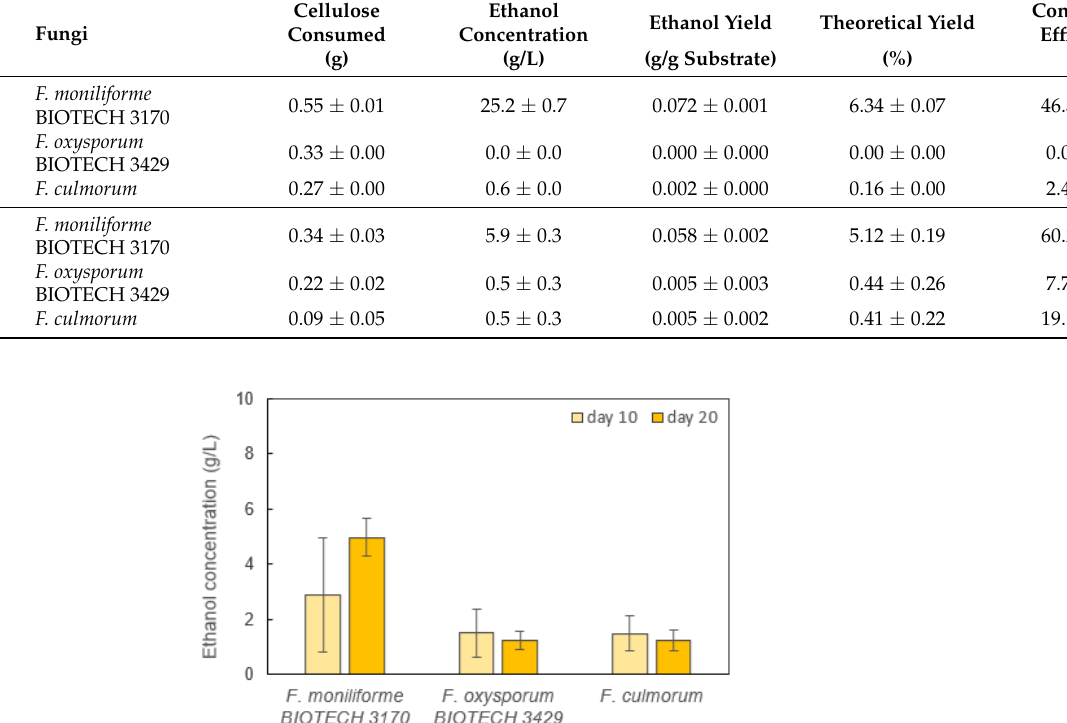
Table 1. Performance parameters for ethanol production from cellulose at solid-state and submerged culture conditions by various fungi after 20 days.